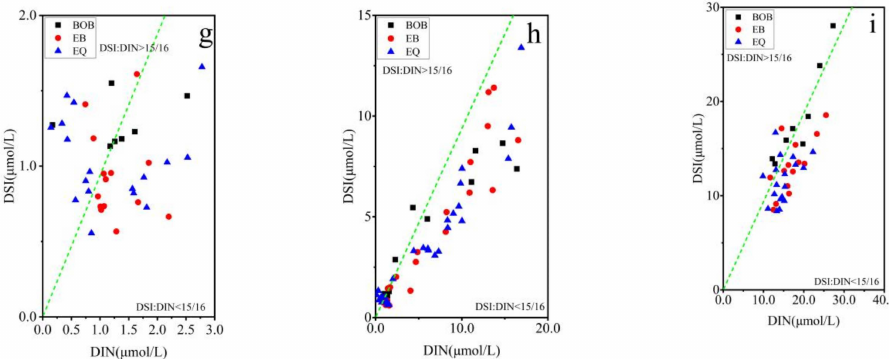
Figure 4. Distribution of pico in DIN and DIP. ( a ) Surfer (3 m, 25 m), ( b ) middle (50 m, 75 m, 100 m), and ( c ) bottom (150 m, 200 m). Distribution of pico in DSI and DIP. ( d ) Surfer (3 m, 25 m), ( e ) Middle (50 m, 75 m, 100 m), and ( f ) Bottom (150 m, 200 m). Distribution of pico in DSI and DIN. ( g ) Surfer (3 m, 25 m), ( h ) middle (50 m, 75 m, 100 m), and ( i ) bottom (150 m, 200 m). The dashed line indicates the Redfield ratio of N:P = 16:1, Si:P = 15:1, Si:N = 15:16. Bay of Bengal (BOB), the Equator (EQ), and the eastern border of the Indian Ocean near Sumatra (EB), Dissolved Inorganic Nitrogen (DIN), Dissolved Inorganic Phosphorus (DIP), Dissolved Silicate (DSI).